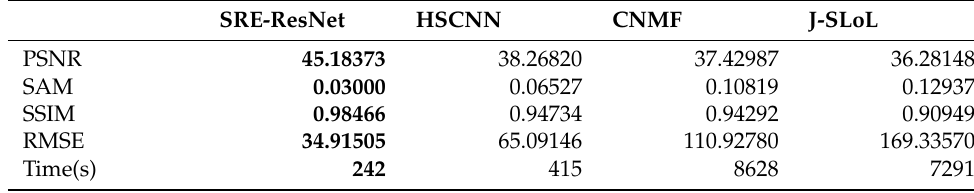
Table 4. Quantitative fusion evaluation results of Dataset I.